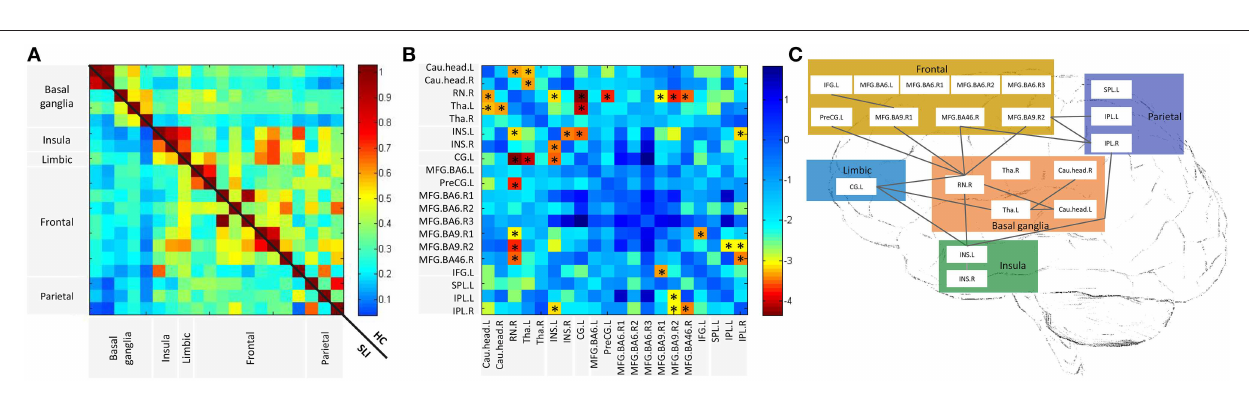
FIGURE 2 | Altered BG-cortical functional connectivities in SLI patients. (A) Mean functional connectivity in SLI and HC groups. The Color bar indicates the correlation values for each region pair. (B) Differences between SLI and HC in BG-cortical connectivity. Color bar indicates altered functional connectivity values (SLI minus HC) for each region pair. Blue cells represent significant correlation differences between ROIs ( t -test, FDR-corrected, q < 0.05). (C) Brain map representation with altered correlations in the BG-cortical network. Significantly decreased connections in SLI patients are shown. There were no increased connections observed in SLI patients. BG, basal ganglia; SLI, silent lacunar infarct; FA, fractional anisotropy; HC, healthy control, FDR, false discovery rate; ROI, regions of